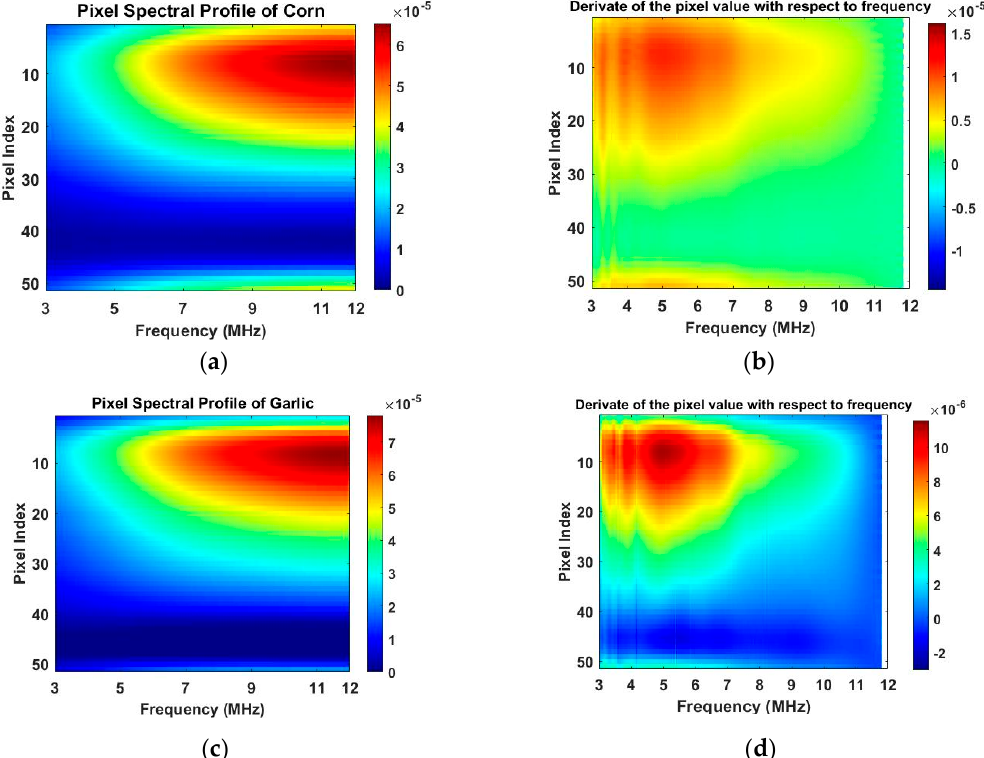
Figure 10. ( a ) Conductivity spectral value of pixel for corn sample. (Colorbar units: mS/cm) ( b ) Derivate of pixel value with respect to frequency for corn. (Colorbar units: mS/cm Hz) ( c ) Conductivity spectral value of pixel for garlic sample. (Colorbar units: mS/cm) ( d ) Derivate of pixel value with respect to frequency for garlic. (Colorbar units: mS/cm Hz).